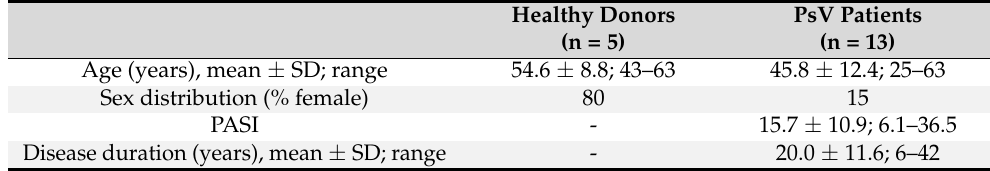
Table 2. Demographic and clinical characteristics of study participants who donated control skin